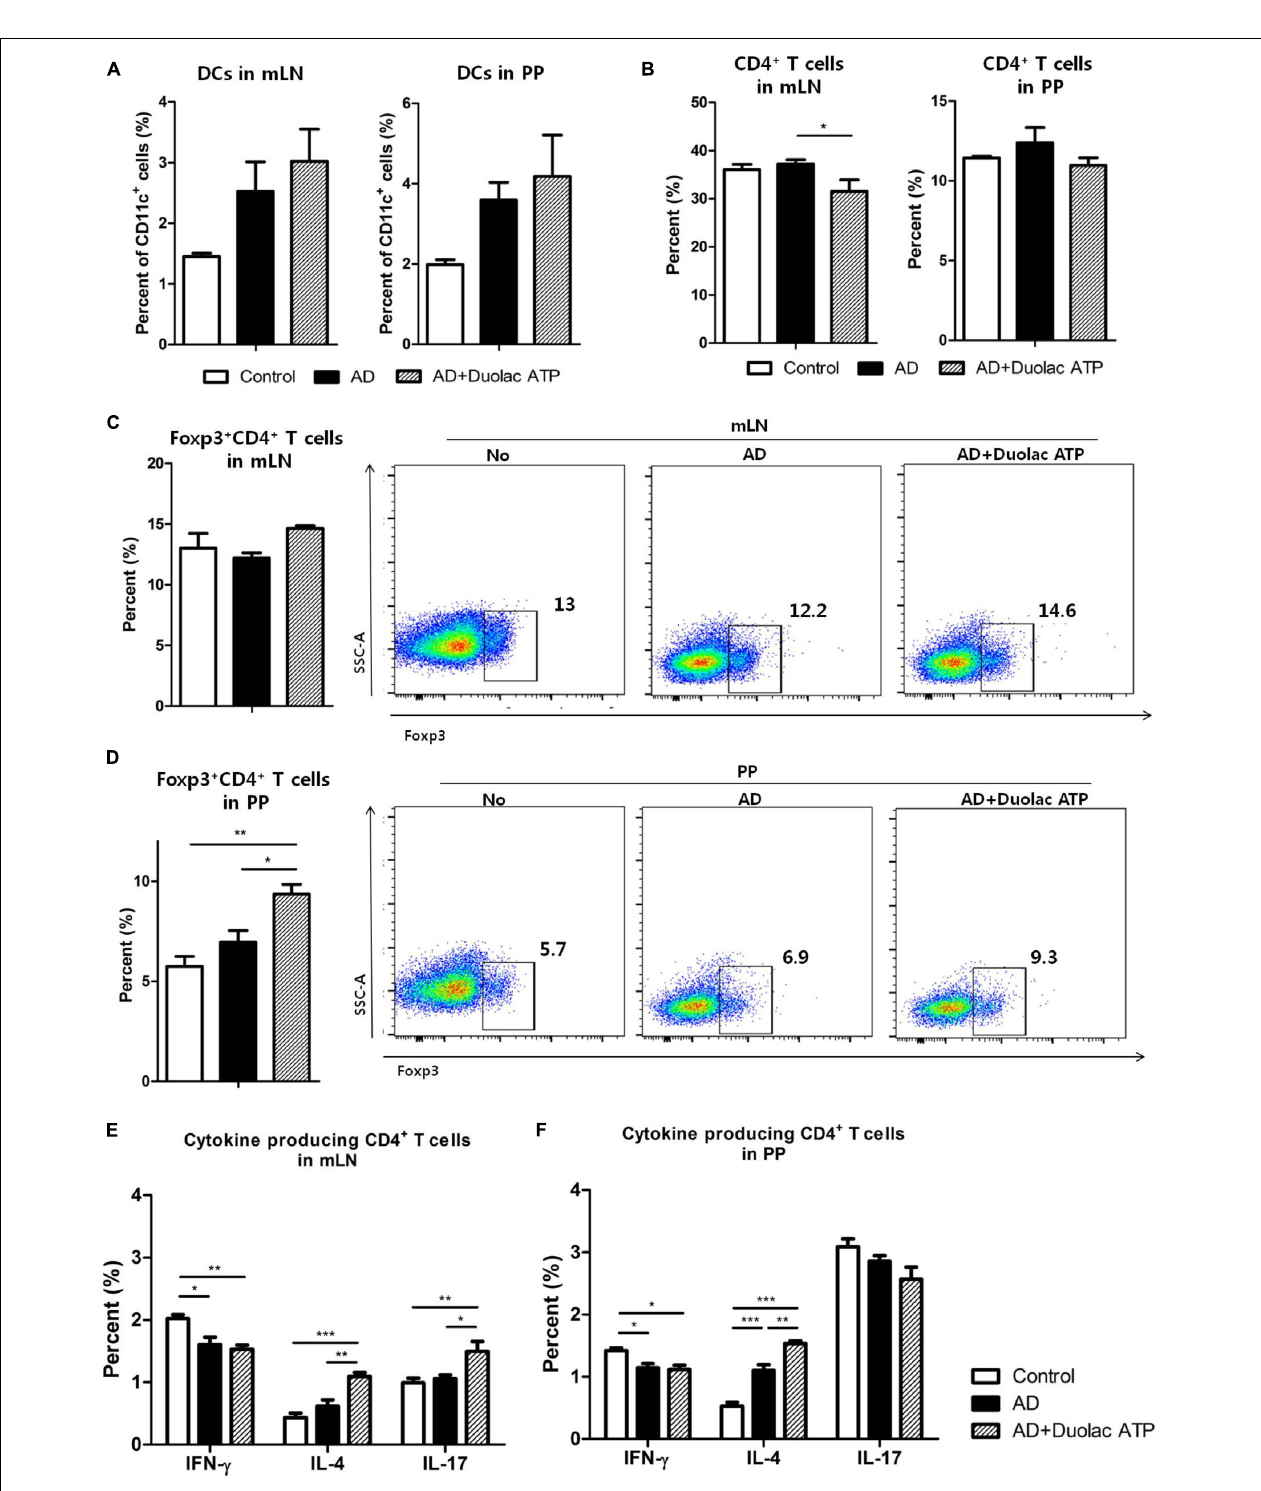
FIGURE 6 | Composition of immune cells from mLN and PP in DNCB-sensitized Nc/Nga mice treated with Duolac ATP. Nc/Nga mice were sensitized by exposing them to DNCB twice a week for 3 weeks. They were then subjected to oral administration of Duolac ATP. Mesenteric lymph node (mLN) and Peyer’s patches (PP) collected at week 4 were used to make single cells, which were used to examine the composition of immune cells. The percentages of (A) DCs, (B) CD4 + T cells, and Foxp3 + CD4 + T cells from (C) mLN and (D) PP were examined using flow cytometry. mLN and PP cells were stimulated with PMA/ionomycin in the presence of brefeldin A for 4 h. IFN-gamma, IL-4, and IL-17 producing CD4 + T cells from (E) mLN and (F) PP were examined after intracellular staining using flow cytometry. Data are representative of at least three experiments. ∗ P < 0.05, ∗∗ P < 0.01, ∗∗∗ P < 0.001 using one-way ANOVA with Tukey’s multiple comparison test. Bars indicate mean ±